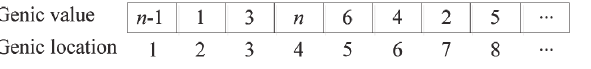
Figure 2. Detailed structure of a